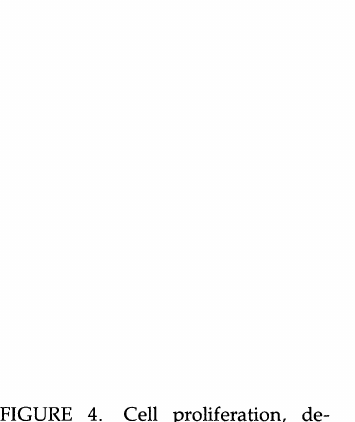
FIGURE 4. Cell proliferation, de- tected by BrdU incorporation, in the ileal and jejunal PPs following treat- ment for 7 days with 2 mg dexamethasone/kg BW (postdex). Ileal PP: a (D.32mpostdex); b (D.54-- postdex); and c: (D.98upostdex). BrdU incorporation was consistently detected in villus crypt epithelium and scattered cells in the interfollicu- lar region (if). Foci of proliferating cells were detected in follicles (f) on D.32 posttreatment, but the size of this proliferating population did not increase beyond D.54 posttreatment. The muscularis (ms) is indicated be- neath the follicles. Jejunal PPs: d (D.32Mpostdex); e (D.54mpostdex); and f: (D.98--postdex). A high level of BrdU incorporation was evident within the lymphoid follicles (f) at all times posttreatment and was associ- ated with a gradual increase in follicle size. The pattern of BrdU incorpora- tion in the villus crypt epithelium, interfollicular region (if), and dome region (d) remained constant. Magni- fication: a-f (bar [in a] 350